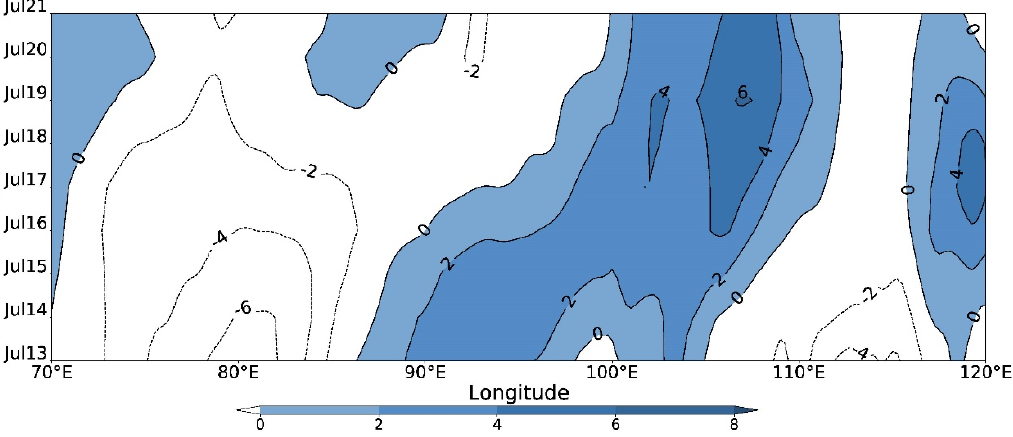
Figure 7. Time ‐ longitude sections of 850 hPa meridional wind anomaly along the equator from 13 July to 21 July (units : m s − 1 ; the shading indicates the positive